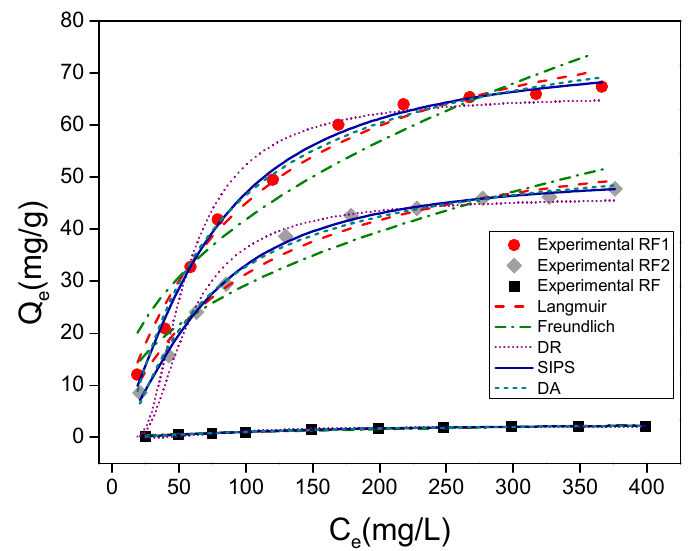
Figure 6. Adsorption isotherms of MO in room temperature conditions, adsorbent mass 100 mg, fixating t c in 120 min.